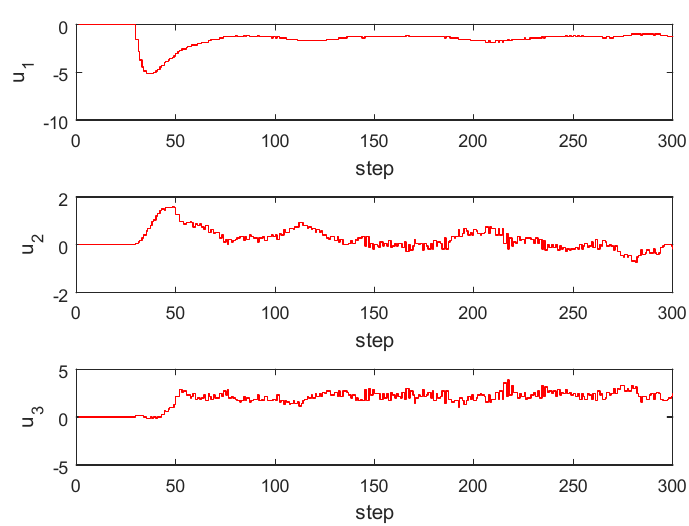
Figure 8. GPC with the 9th order internal model—closed loop simulation of 300 time-steps; dashed line is a set point, solid is a CV, and control parameters as: control horizon (cid:1840) (cid:3048) = 20 , prediction horizon (cid:1840) = 400 , and the (cid:1844) matrix = identity matrix